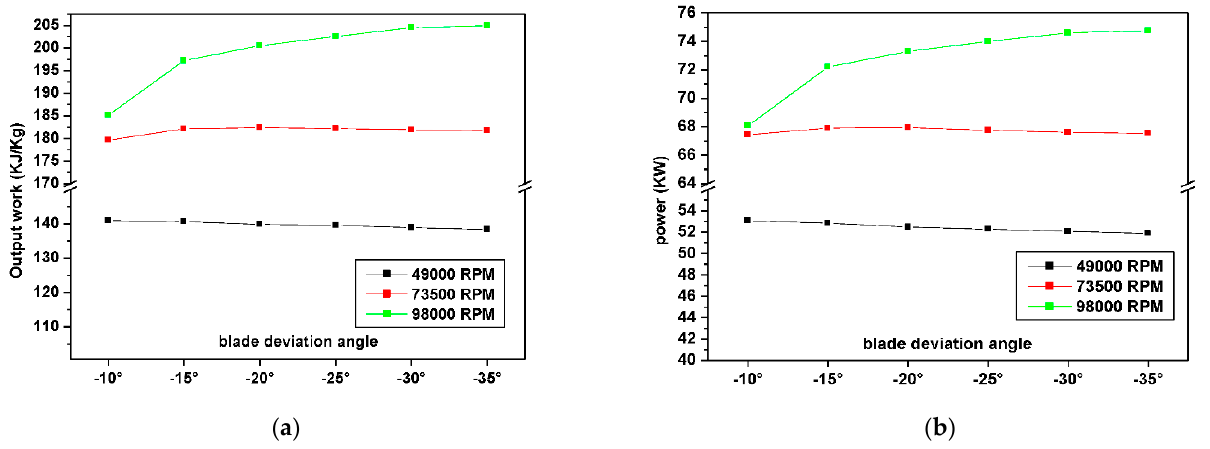
Figure 16. The investigation of the deviation blade effect: ( a ) output work for different deviation blade angles; ( b ) power for different deviation blade angles. Table 2. The blade area in mm² resulted in different deviation blade angle.